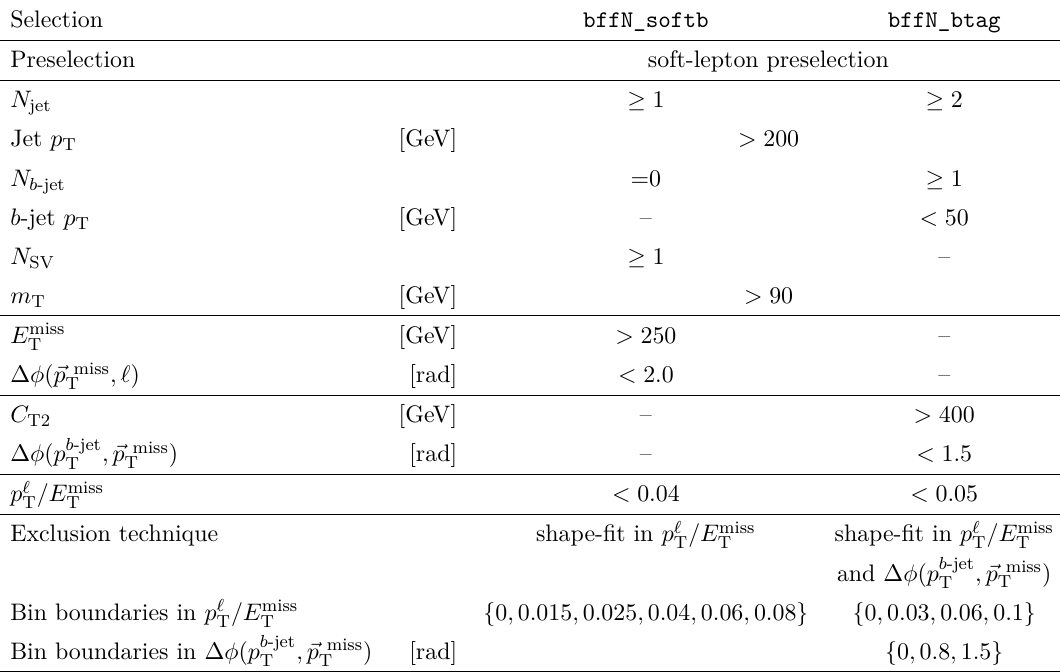
Table 7. Event selections defining the signal regions bffN_softb and bffN_btag